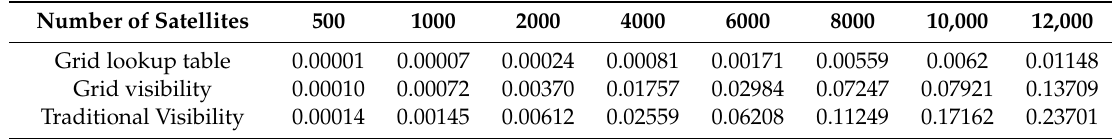
Table 4. Visibility calculation results